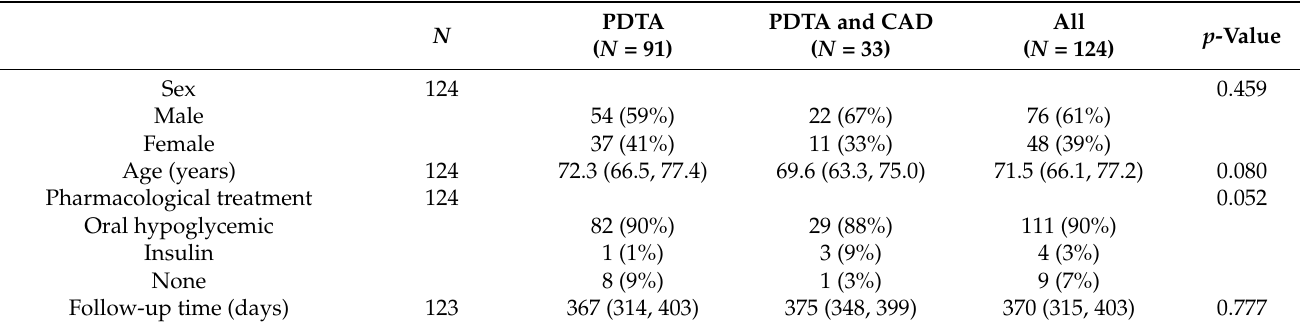
Table 1. General characteristic of subjects included in the study. Data are expressed as median (I, III quartile) for continuous variables and absolute numbers (percentage) for categorical